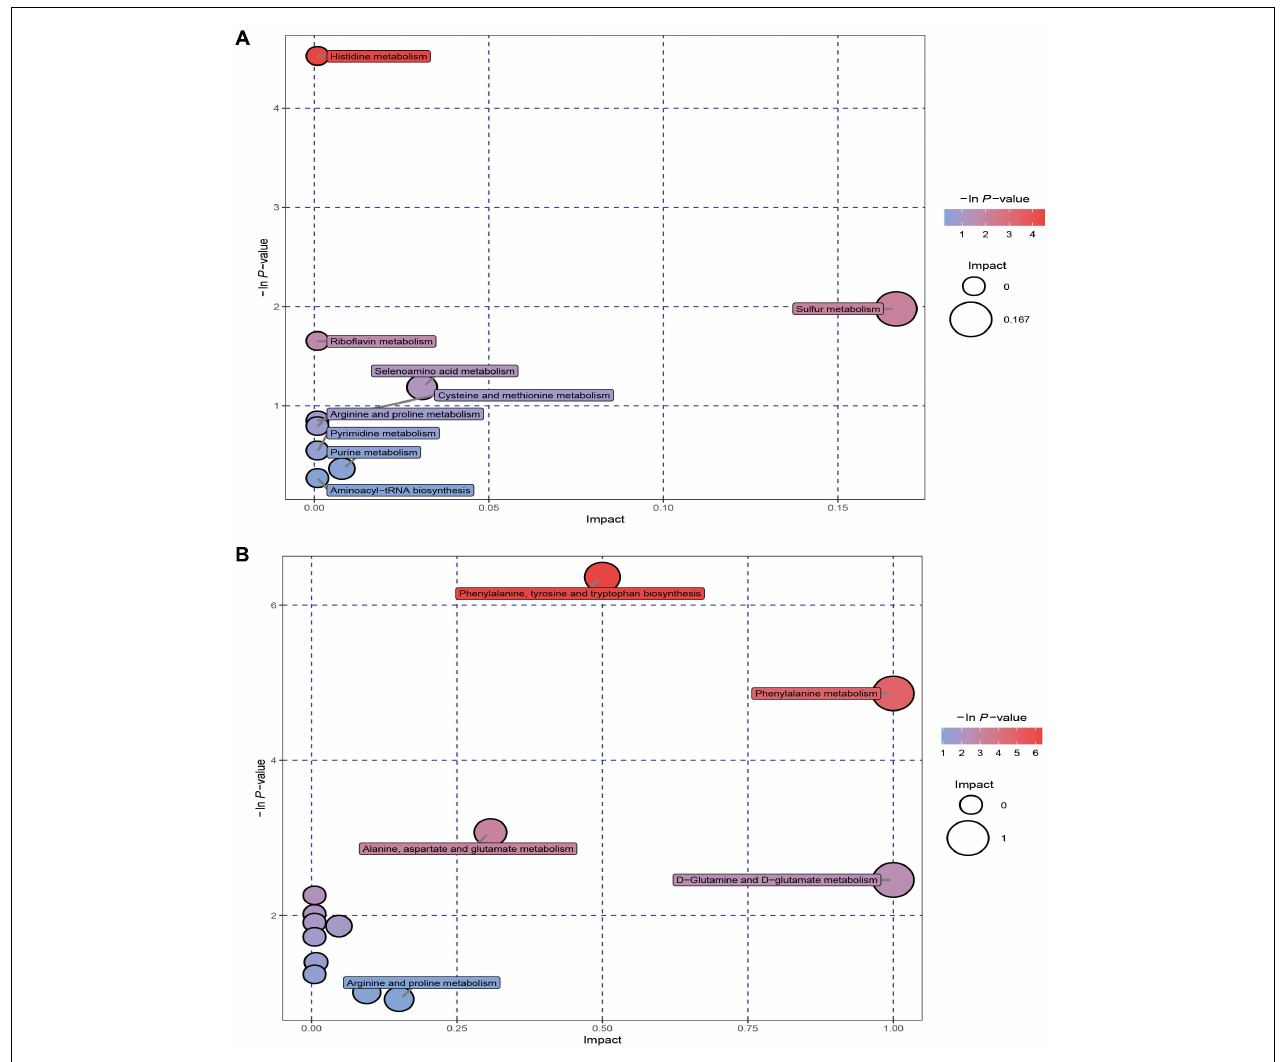
FIGURE 5 | Metabolome view map of significant metabolic pathways characterized in the coelomic fluid of S. nudus for groups EG2 and EG5. (A,B) are derived from POS and NEG, respectively. Significantly changed pathways based on enrichment and topology analysis are shown. The x - and y -axes represent pathway enrichment and pathway impact, respectively. Large sizes and dark colors represent major pathway enrichment and high pathway impact values,